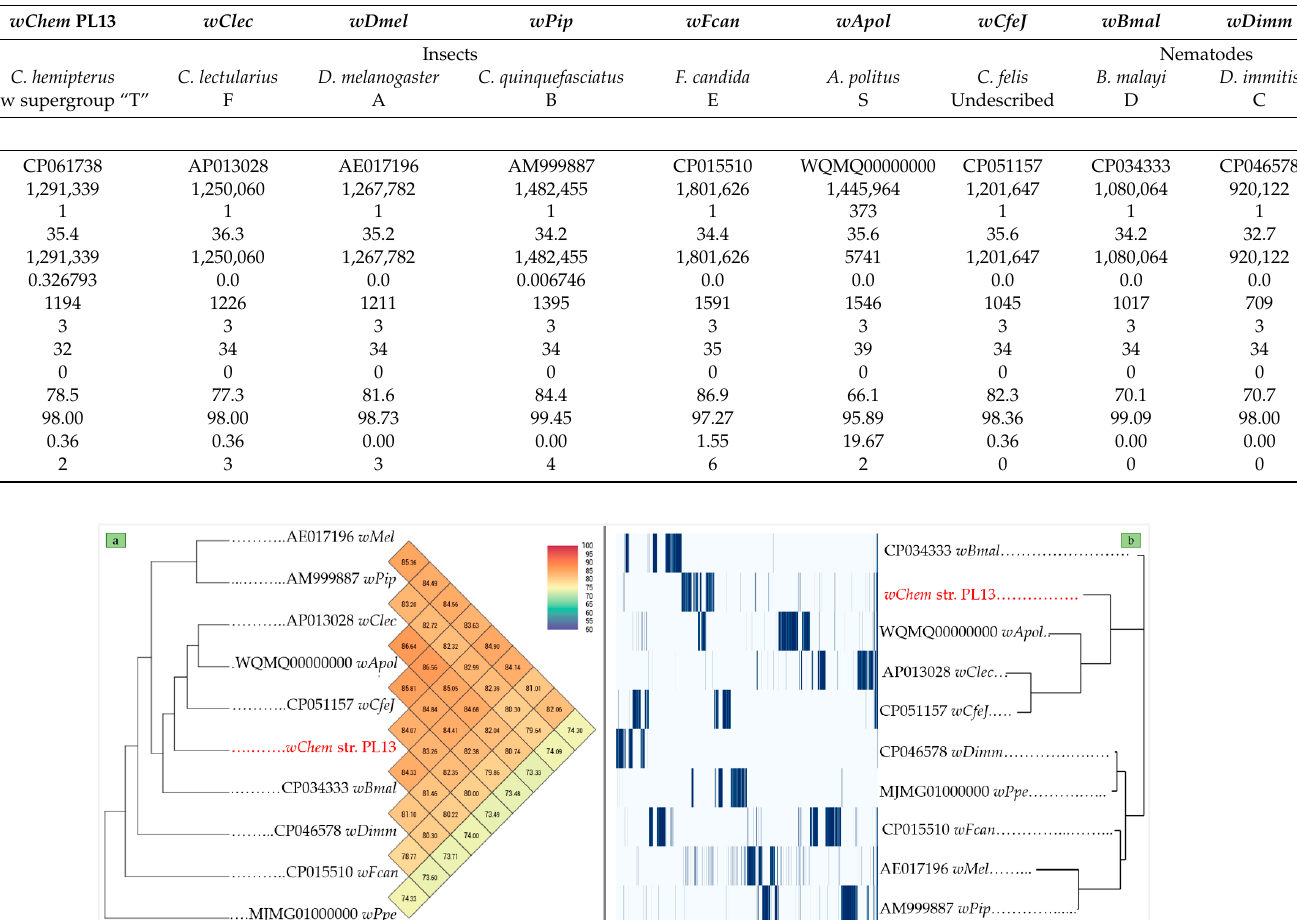
Table 1. General features of wChem PL13 and other Wolbachia genomes.